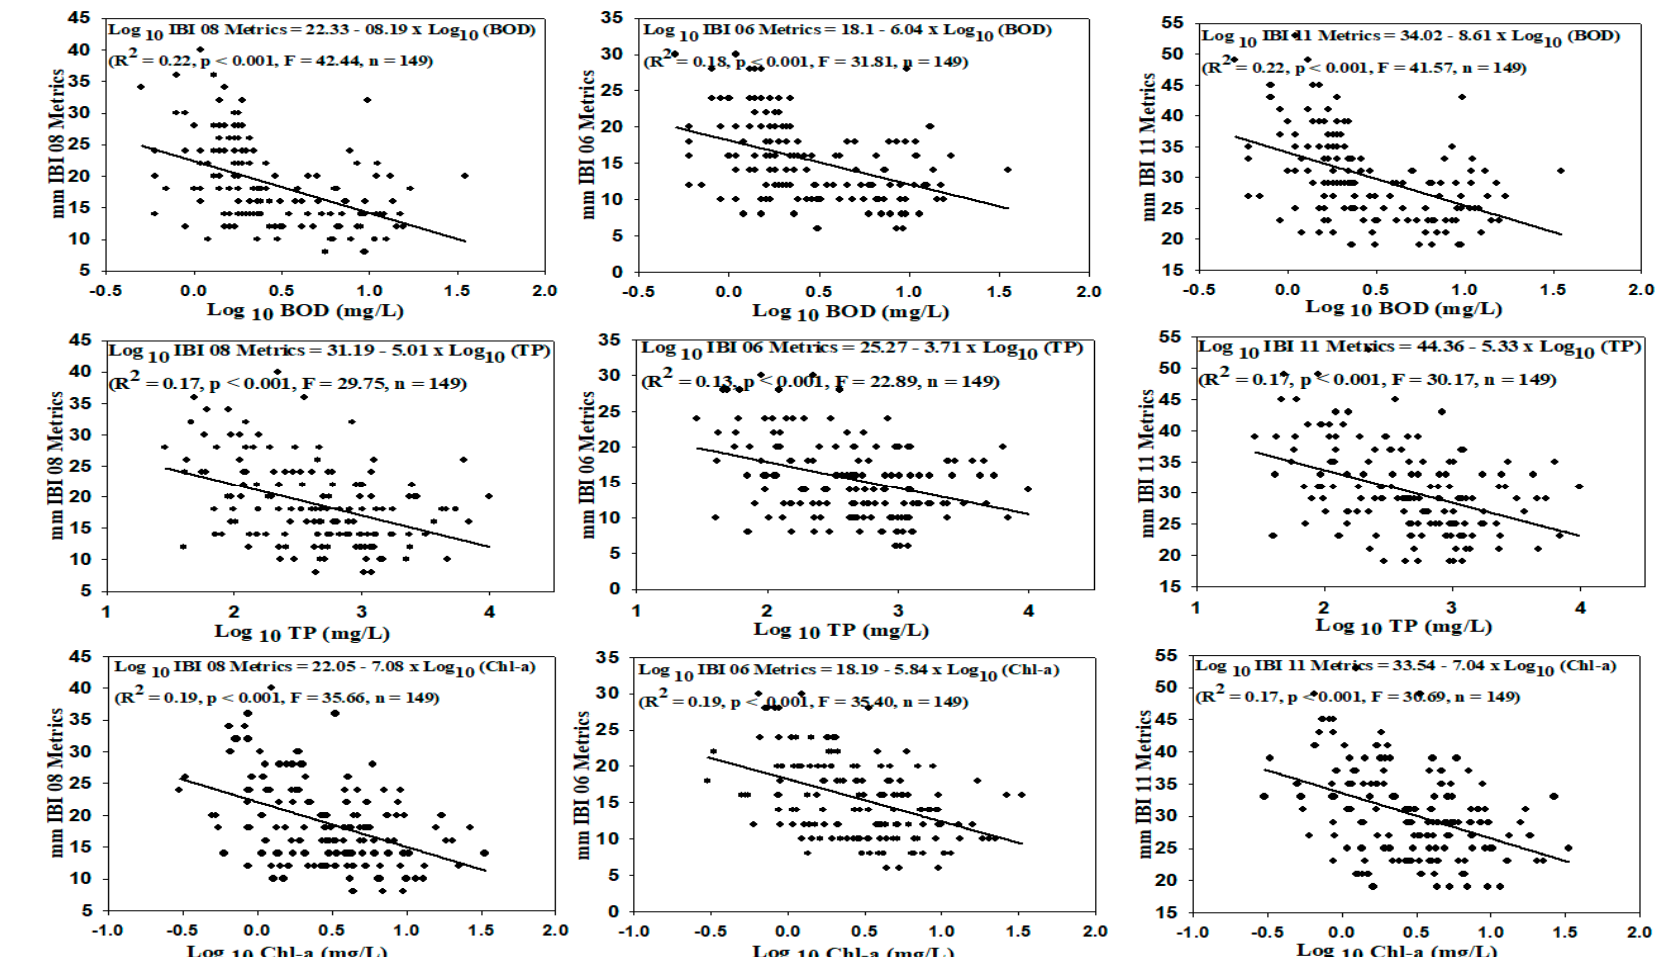
Figure 4. Regression relationship between the three IBI models and BOD, TP, and CHL-a in Geum River watershed.